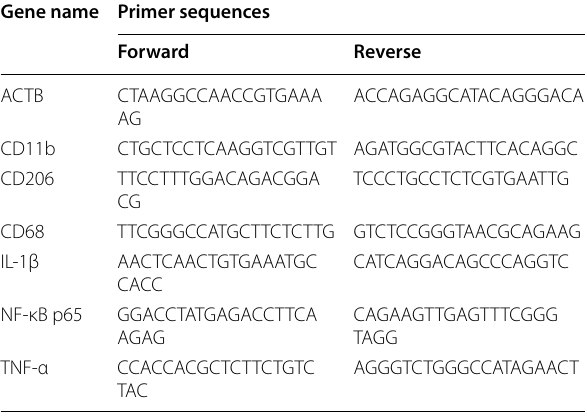
Table 2 The information of primers used in this study Gene name Primer